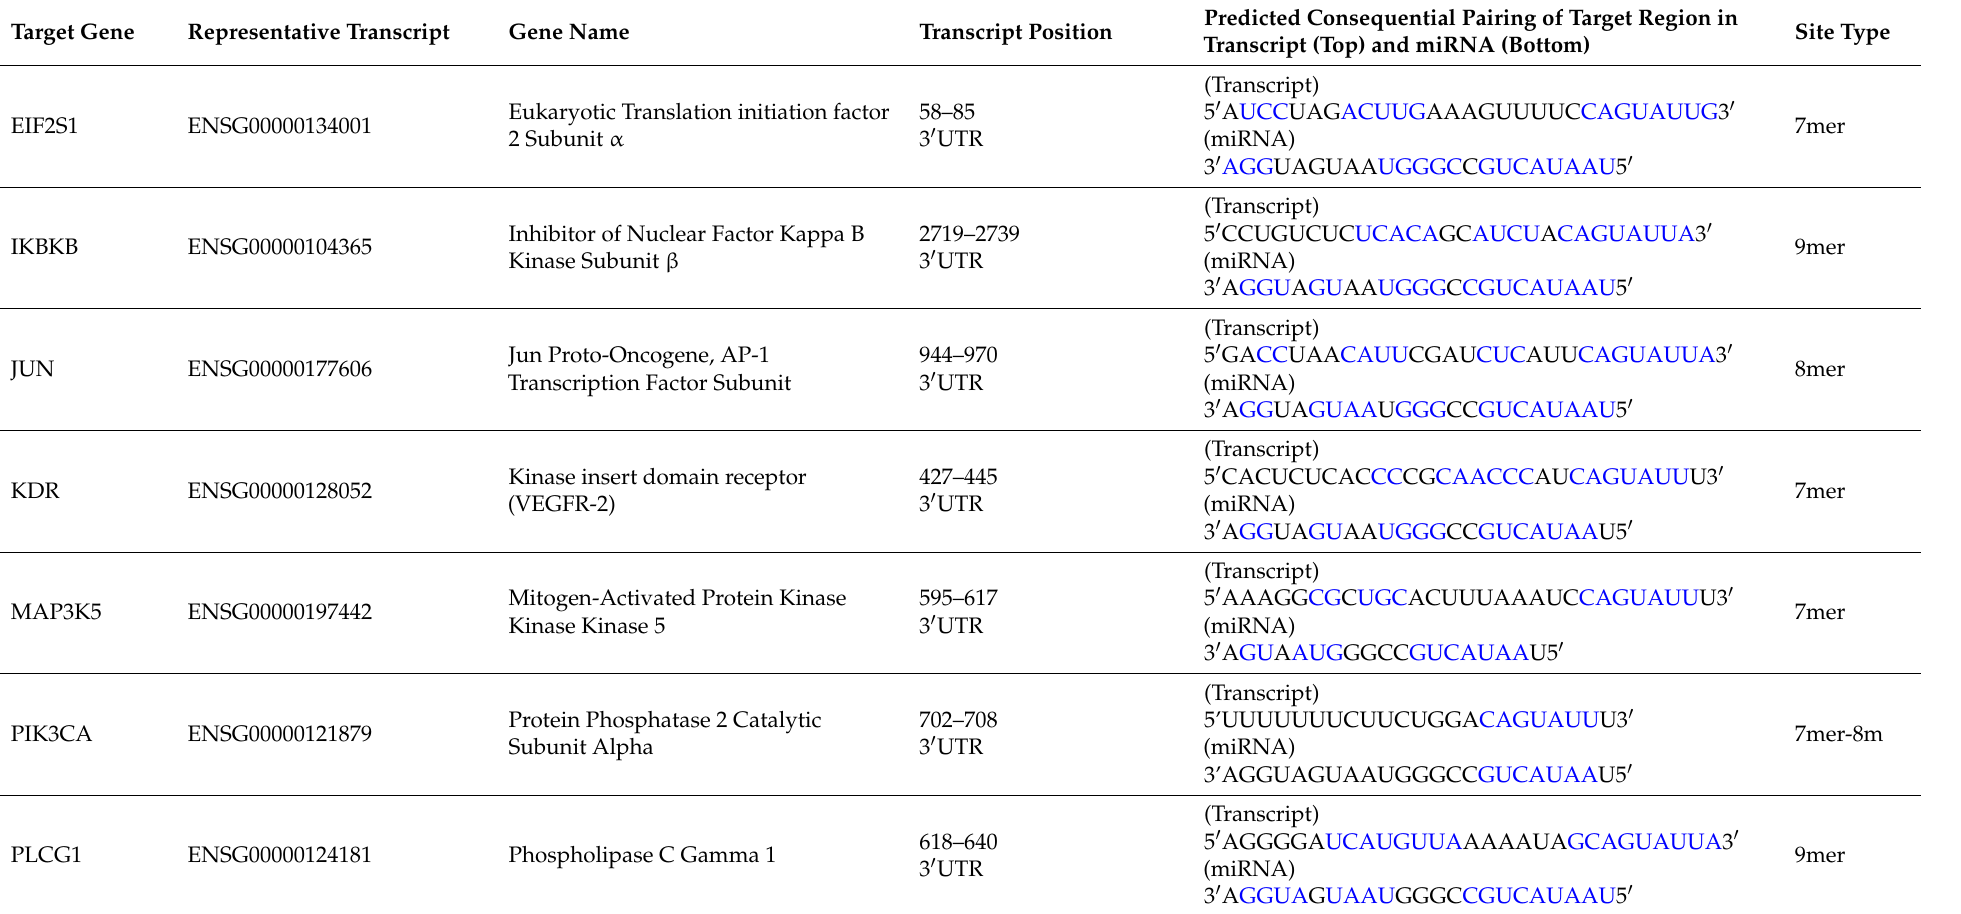
Table 1. Predicted consequential pairing of target regions in the transcript and